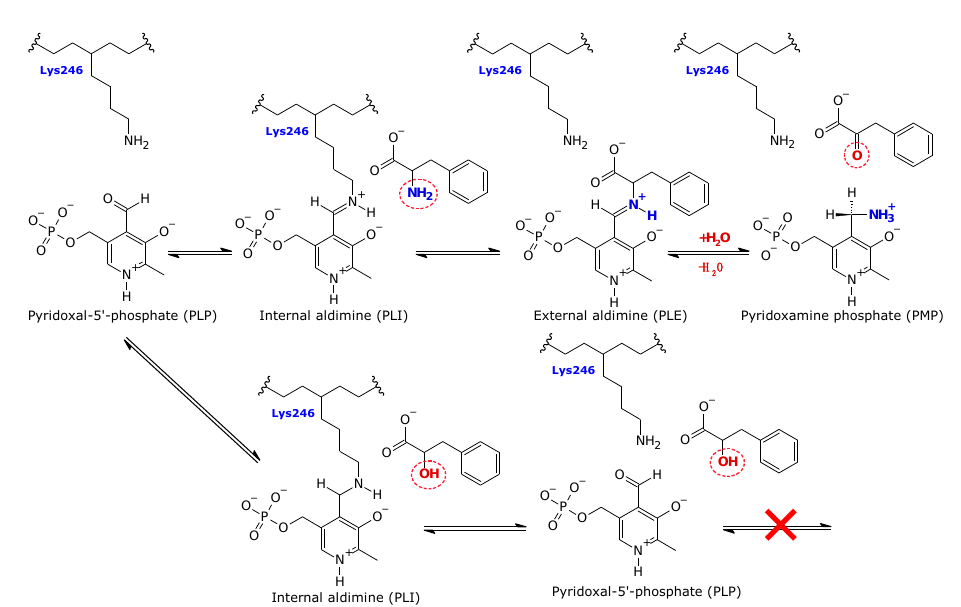
Figure 1. The mechanism of the transamination reaction, catalyzed by Psy ArAT (upper line), and broken by the presence of the inhibitor, hydroxy-analog of phenylalanine (lower line).